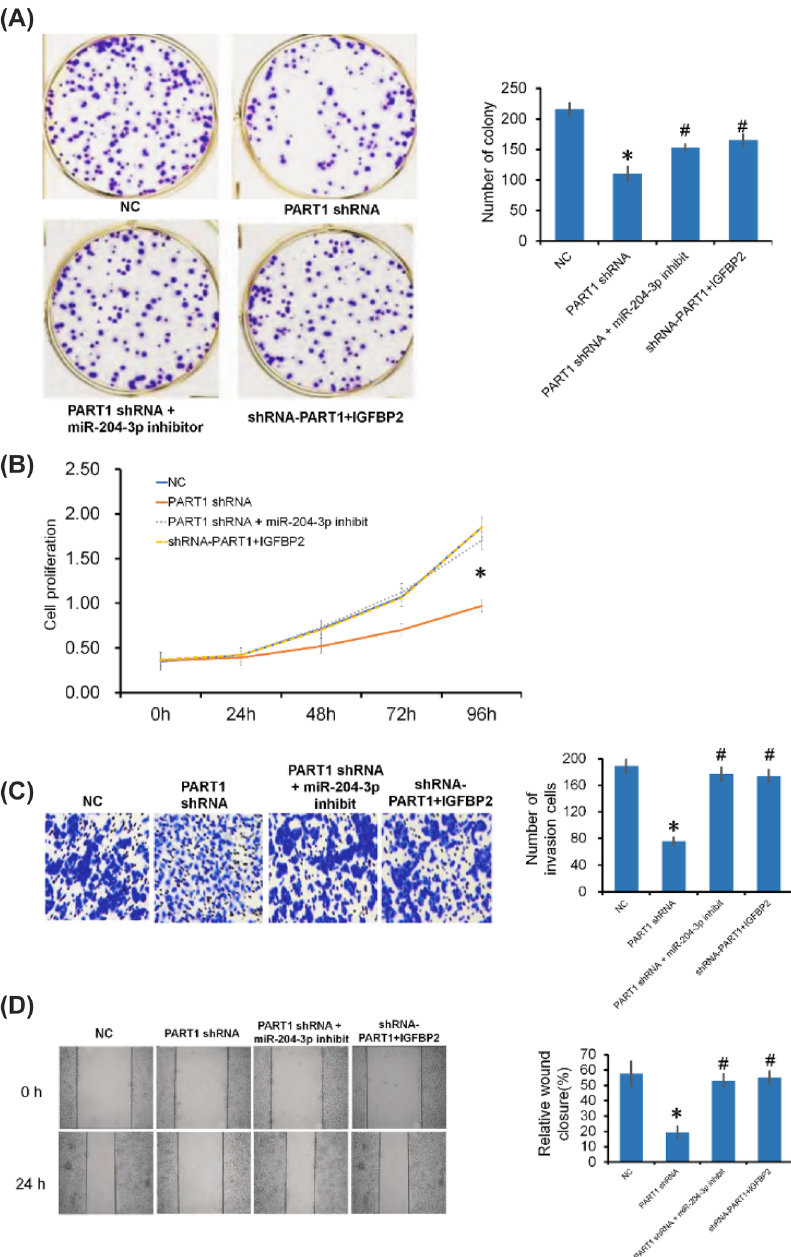
Figure 6: The downregulation of PART1 inhibited the proliferation, invasion, and migration of A549 cells by regulating the miR-204-3p-targeted IGFBP-2 pathway. (A) Colony formation of NC, PART1-shRNA, PART1-shRNA + miR204-3p inhibitor, and PART1-shRNA + IGFBP2 cells. (B) Cell proliferation, as determined by CCK-8 assay. (C, D) Cell invasion and wound healing assays of NC, PART1-shRNA, PART1-shRNA + miR204-3p inhibitor, and PART1- shRNA + IGFBP2cellsbyTranswellinvasionassayandwoundhealingassay.**p<0.05,PART1-shRNAgroupcomparedwithNCgroup; # p<0.05compared with PART1-shRNA